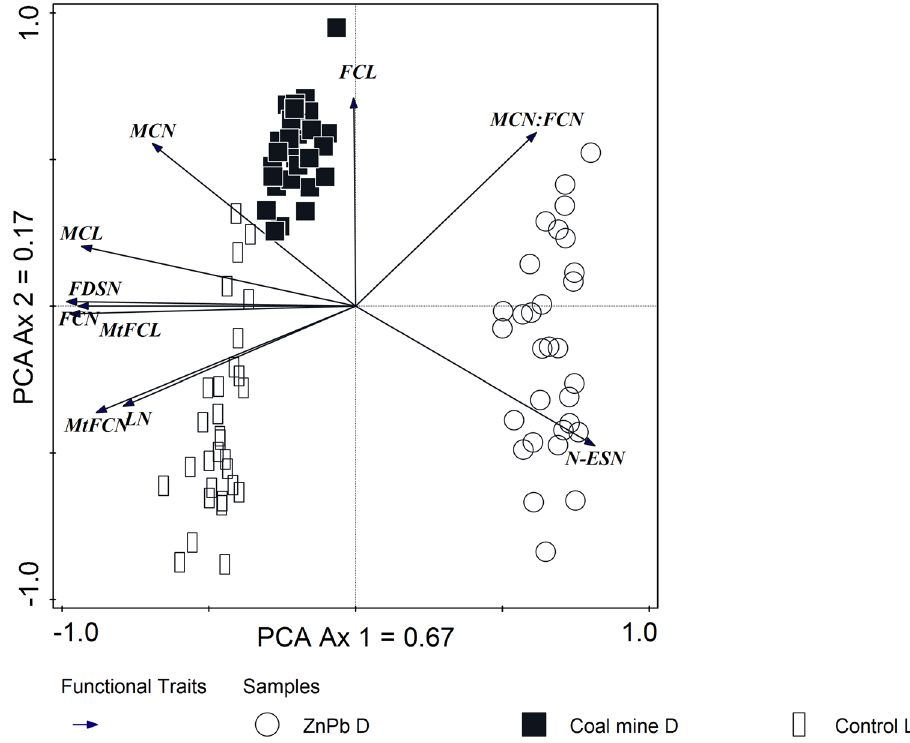
Figure 1. PCA analysis of the differentiation of the biometric traits of Betula pendula on Zn-Pb D, Coal mine D and unpolluted Control L sites. The traits abbreviations are given in Table 2a.